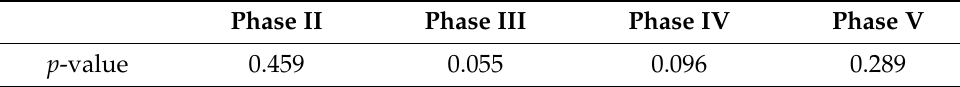
Table 2. Global p -value per